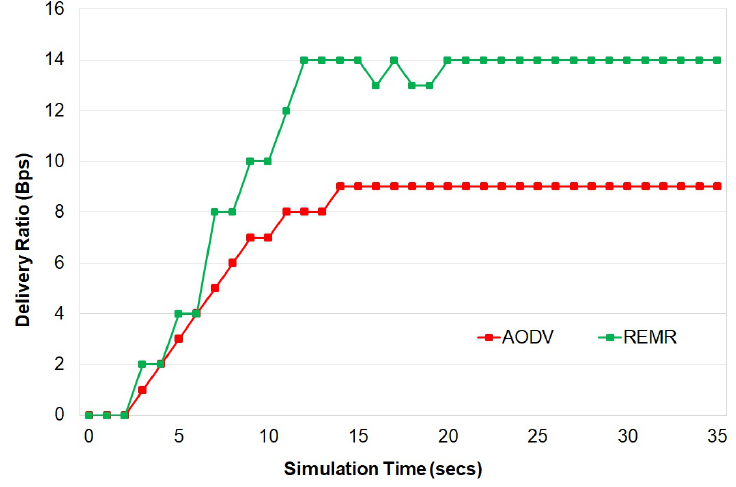
Figure 4. Delivery Ratio